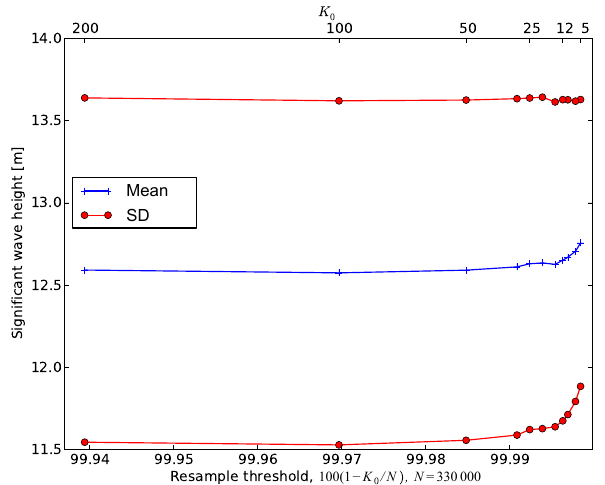
Figure 5. Mean and standard deviation on 100-year in-sample re- turn estimates based on M = 10000 bootstrap resamples for various choices of resample threshold K 0 for the sample in Fig. 2. A min- imum of k = 3 entries are required to form the return estimate (see Eq. 7). For choices of K 0 smaller than 30 (corresponding to a ratio r = K 0 /k = 10) the bootstrap resamples are biased high.